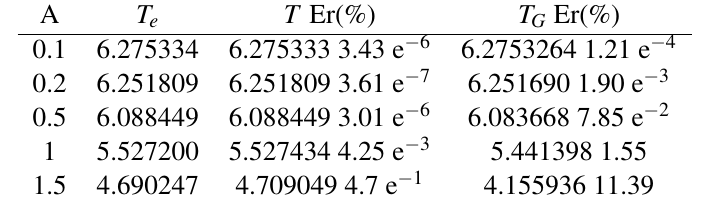
Table 3 Comparison of the approximate periods with exact periods T e of ¨ x + x = − x ˙ x 2